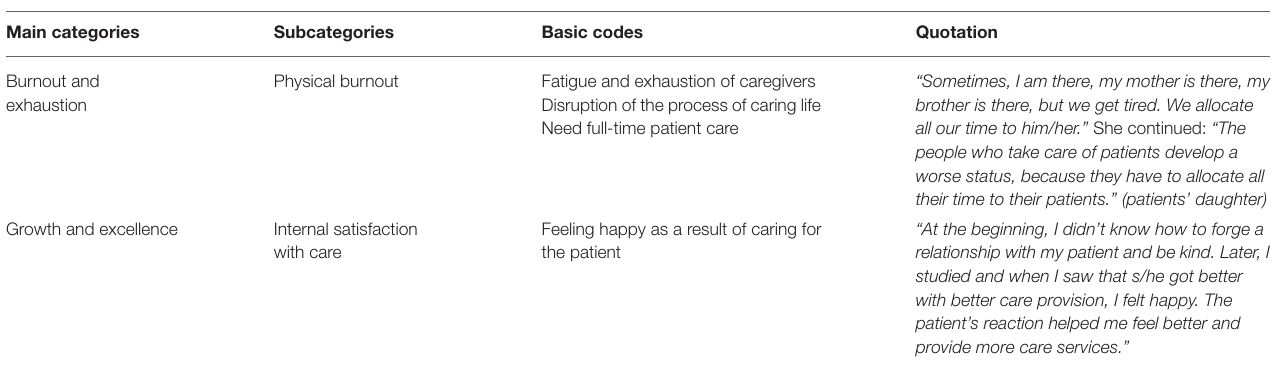
TABLE 1 | Detailed information about the main categories and